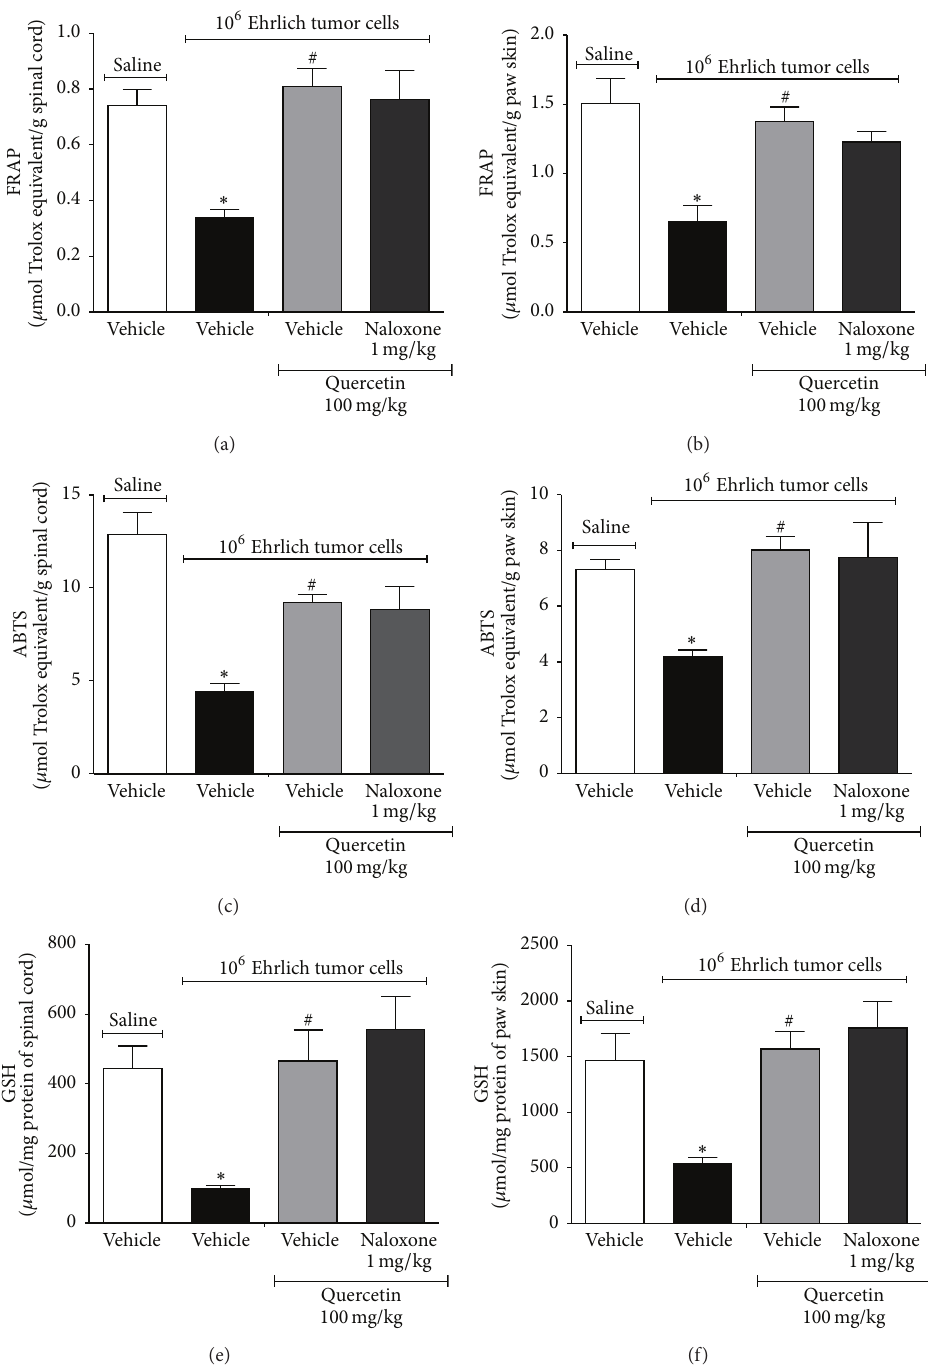
Figure 10: Naloxone did not reverse the effect of quercetin in reducing Ehrlich tumor cells-induced oxidative stress. Mice were treated with quercetin (100mg/kg, i.p., starting 10min after tumor administration) during 8 days after the injection of Ehrlich tumor cells (1 × 10 6 or 1 × 10 7 cells/25 𝜇 L) or saline and, in the 8th day, one group of mice that received quercetin was also treated with naloxone (1mg/kg i.p. diluted in saline) or its vehicle 1h before the treatment with quercetin. Three hours after the treatment with quercetin, samples of spinal cord and paw skin were collected for the oxidative stress assays. The FRAP and ABTS ability of spinal cord ((a) and (c), resp.) and paw skin ((b) and (d), resp.) tissues and GSH levels in the spinal cord (e) and paw skin (f) were accessed. Data are presented as means ± SEM of six mice per group per experiment and representative of two separated experiments: ∗ 𝑝 < 0.05 compared to the saline group and # 𝑝 < 0.05 compared to the tumor group. One-way ANOVA followed by Tukey’s